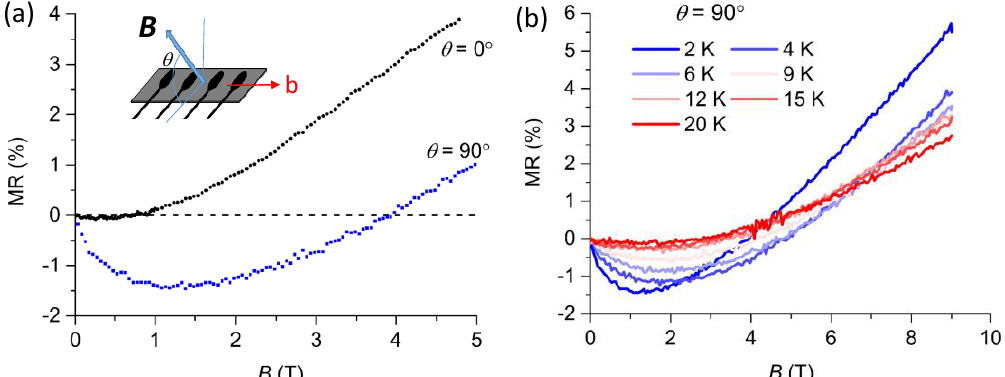
Figure 3. ( a ) The MR (current along b -axis) of β ” -BO3 (sample #1) at 2 K under magnetic field B parallel ( θ = 0°) and perpendicular ( θ = 90°) to the 2D layer. Clear negative MR was observed when θ = 90°. ( b ) The MR for the perpendicular field in the temperature range of 2 – 20 K.